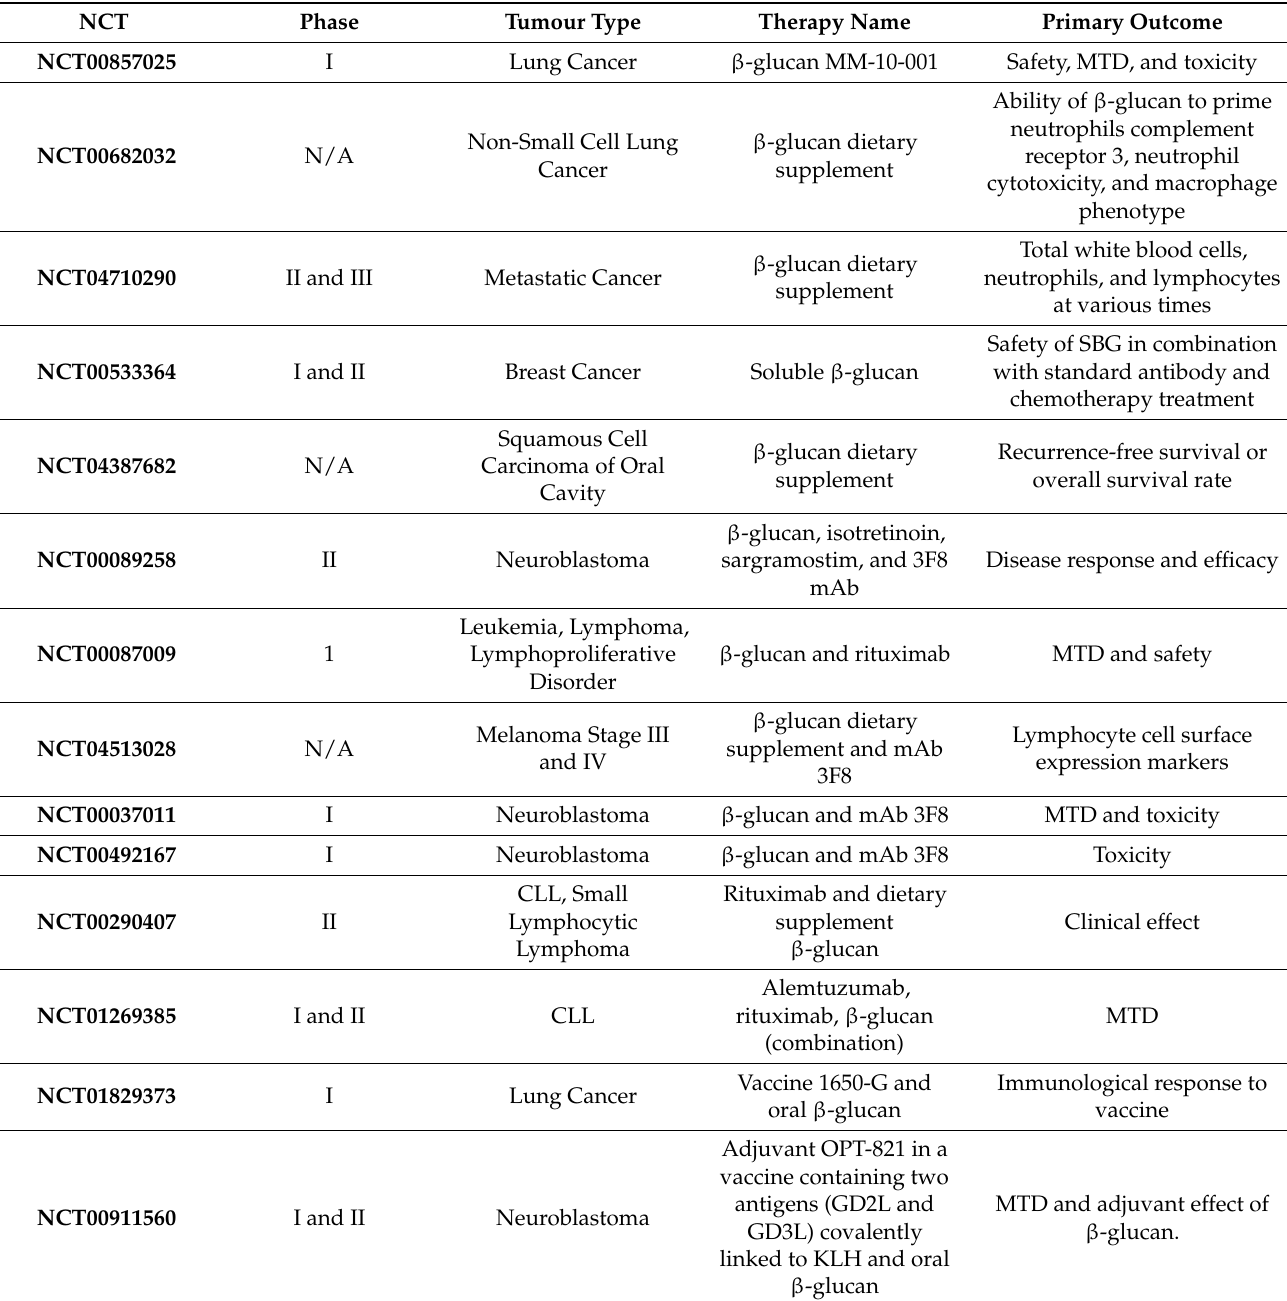
Table 1. Summary of clinical trials investigating the use of β -glucan alone or in combination with other anti-cancer therapies 1